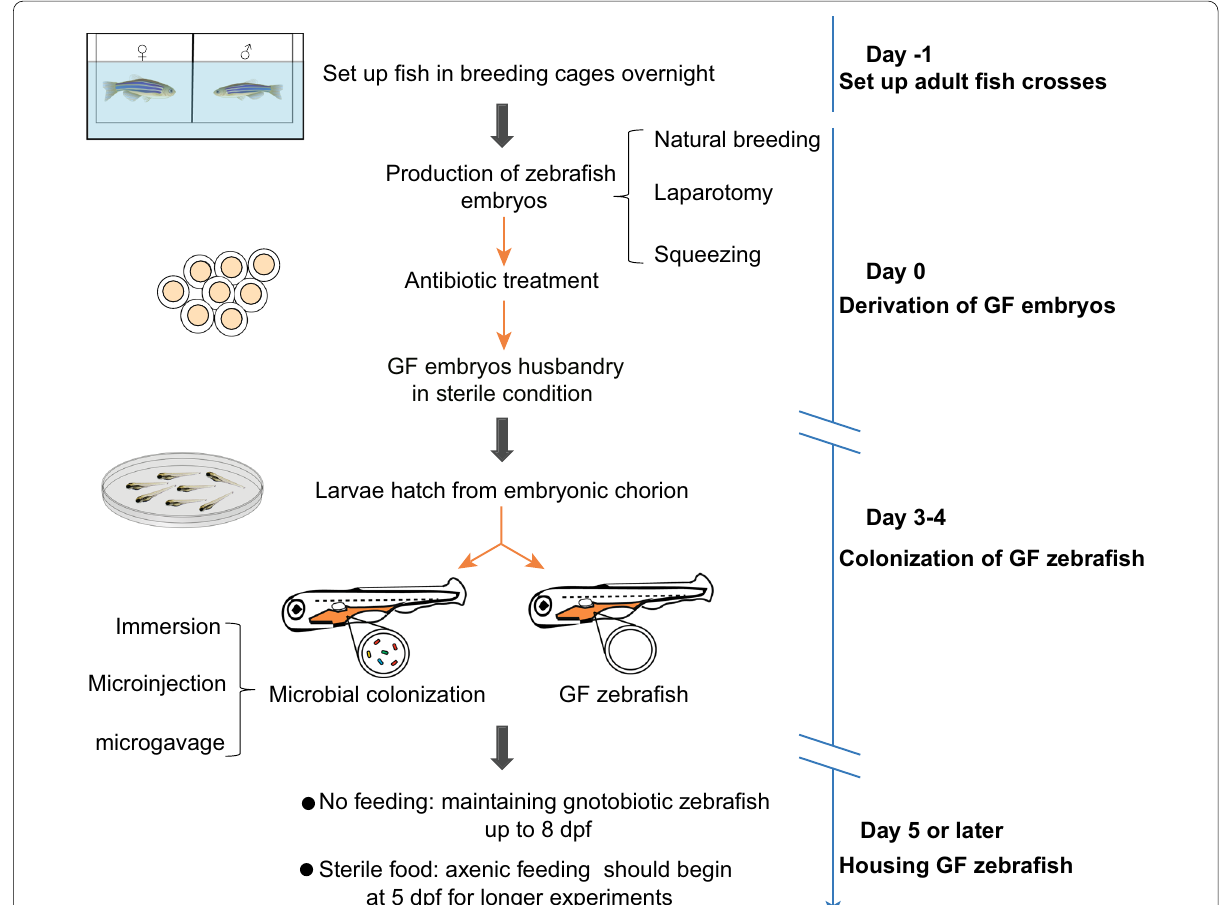
Fig. 2 Overview of generation procedures for germ-free zebrafish. On day -1, pairs of adult zebrafish are placed in breeding cages overnight, with males and females separated using a divider. The next morning (Day 0), embryos are collected, rinsed, and transferred to a petri dish containing a filter-sterilized embryo medium. Three general methods are used to obtain gnotobiotic zebrafish embryos, including natural breeding, laparotomy, and squeezing. After the larvae are transferred into sterile culture flasks or gnotobiotic isolator, they are maintained in an incubator to develop at 28.5 °C. On 4 dpf, GF zebrafish colonized by